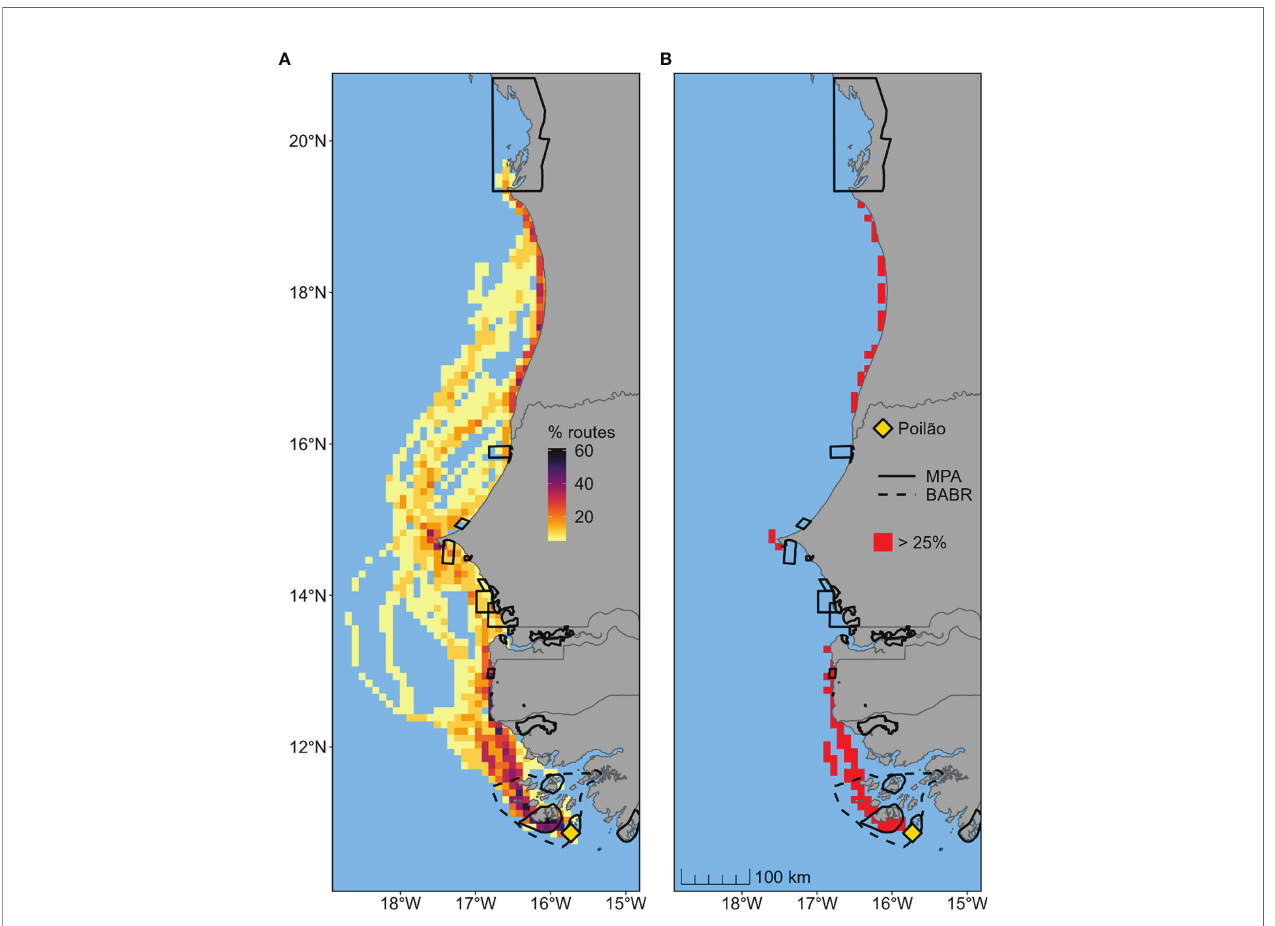
FIGURE 3 | Migration routes of 18 female green turtles ( Chelonia mydas ) travelling from the nesting island in Guinea-Bissau (i.e., Poilão Island) to foraging areas in Senegal, The Gambia or Mauritania. (A) Percentage of overlapping migration routes, de fi ned as 95% probability areas estimated using dynamic Brownian bridge movement models. (B) Identi fi ed high-passage corridors, de fi ned as grid cells used by at least 25% of migrating turtles. Black solid and dotted lines represent existing conservation areas in the region. (Marine Protected Areas [MPA] and UNESCO Bolama-Bijagós Biosphere Reserve